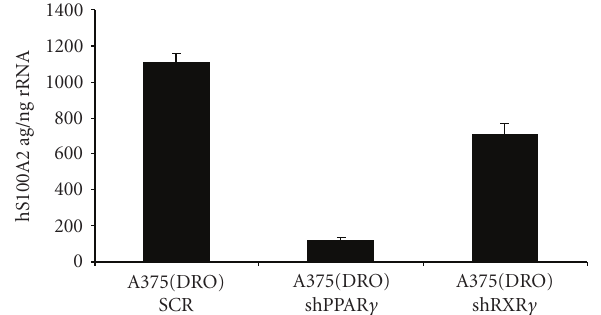
Figure 1: S100A2 mRNA stimulation by TZD/rexinoid treatment is dependent on intact PPAR γ and RXR γ . One microgram of total RNA was used for the S100A2 quantitative reverse transcription- PCR analysis (ABIPRISM7700; Perkin-Elmer), and absolute values were derived from a standard curve using a known amount of sense strand RNA (ag, attograms of sense strand RNA). Isoform RNA was normalized to total input RNA (18s rRNA measured from 1ng of total RNA). A375(DRO) cells were infected with either shPPAR γ or shRXR γ lenteviral particles and then treated with LGD1069/ROSI 1 μ M for 24 hours. S100A2 mRNA levels were compared to levels from A375(DRO) cells infected with the shSCR control under the same treatment conditions.